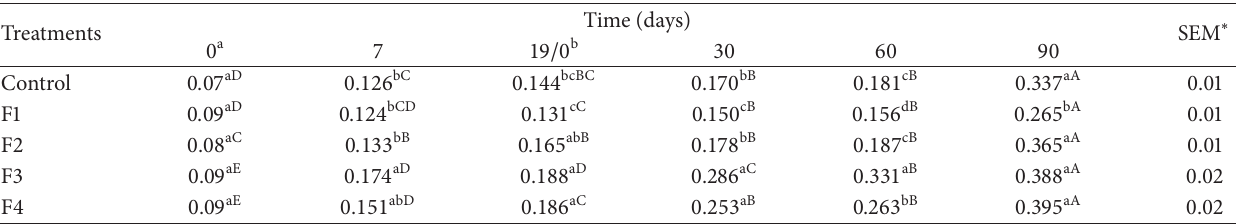
Table 1: Malondialdehyde content ( 𝜇 g MDA/g sample) during curing process and storage of salamis with NaCl reduced or replaced by KCl and/or CaCl 2